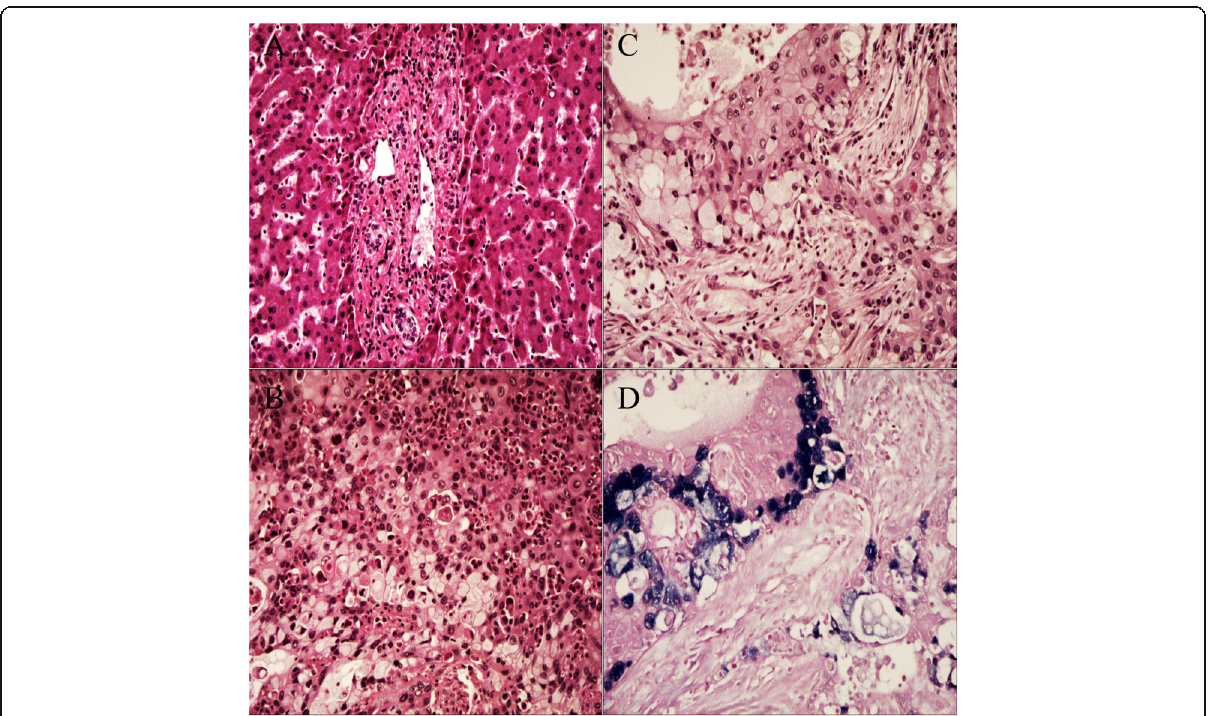
Fig. 2 Pathological results. a Dystrophic arteries and a large number of inflammatory cells, mainly including lymphocyte infiltrations, were observed in the portal area (hematoxylin and eosin (H&E) staining, magnification 100×). b Eosinophil infiltrations were seen in the tumor area (H&E staining, magnification 200×). c H&E staining revealed malignant epidermoid cells and mucus-producing cells with intracytoplasmic mucin. The tumor cells infiltrated into the stroma with occasional keratinization (magnification 200×). d Alcian blue stain-positive material highlights the mucin in mucin-producing cells (magnification